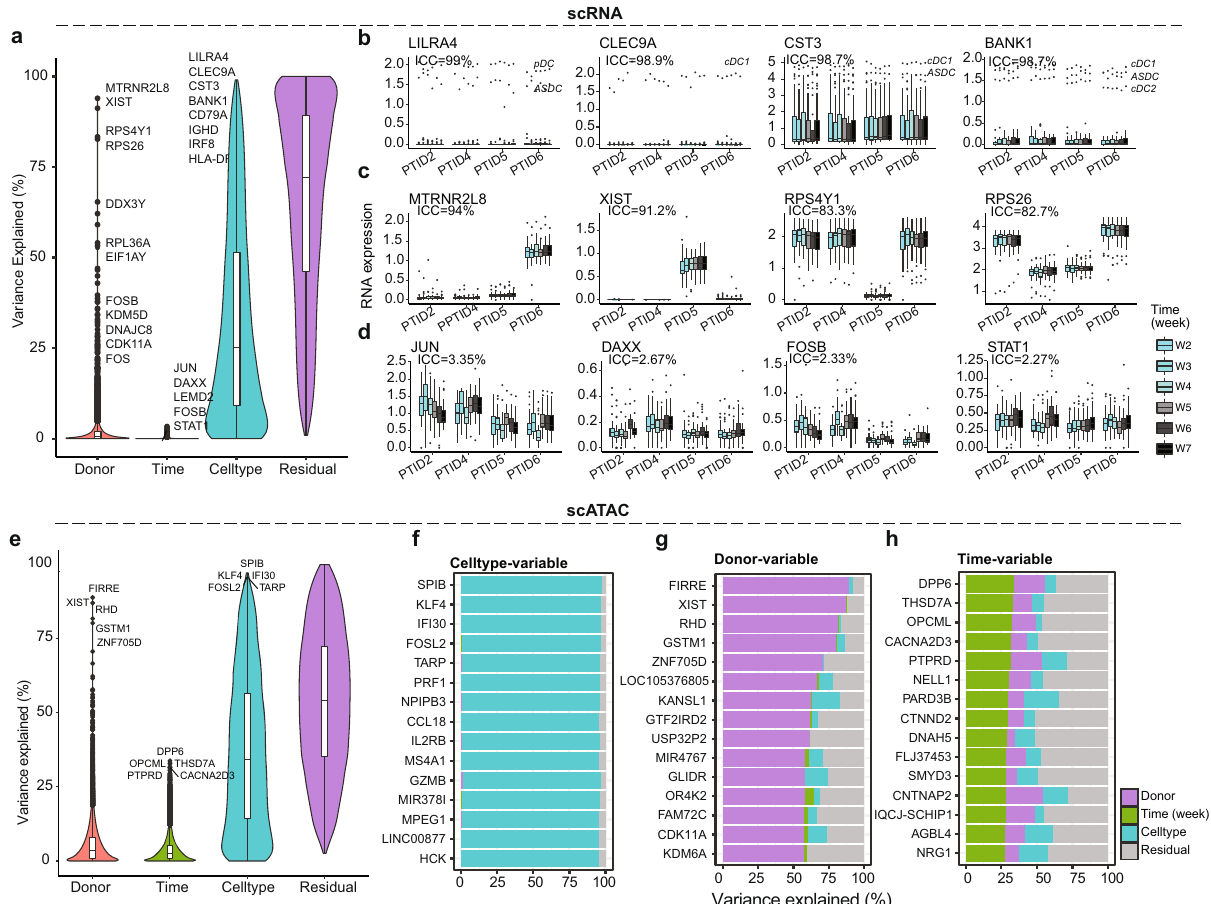
Fig.2|Variancedecompositiononlongitudinalsingle-cellomicsdata.a Overall distributions of variance explained by inter-donor variations (Donor), longitudinal intra-donor variations (Week), variations among cell types (Celltype), or residual variations (Residual) based on scRNA-seq data. The scRNA-seq data was collected on 24 independent peripheral blood mononuclear cell (PBMC) samples from n =4 healthy participants with each participant contributing one sample a week for 6 weeks. The distributions were evaluated based on pseudo-bulk intensities of n =11,191 genes in 19 cell types. b , c Examples of genes whose total expression variance was most explained by inter-cell-type variations ( b ) or inter-donor varia- tions ( c ). d Examples of genes that had the most but still minuscular intra-donor variationsinexpression. b – d Pseudo-bulkintensitiesofthecorrespondinggenesin 19 cell types were displayed in boxplots. e Same as ( a ) but based on scATAC-seq